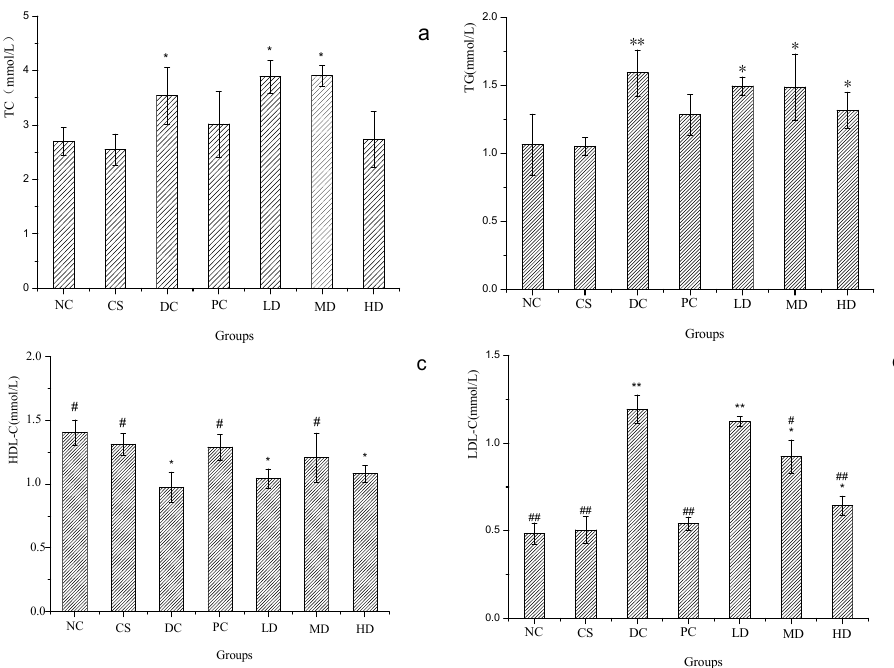
Figure 6. TC ( a ); TG ( b ); HDL-C ( c ) and LDL-C ( d ) of normal and STZ induced diabetic mice. Results were presented as means ± SD ( n = 10). The columns of each index have * p < 0 .05, ** p < 0 .01 vs. NC; # p < 0 .05, ## p < 0 .01 vs. DC. Group abbreviations are as given in the caption of Figure 1.